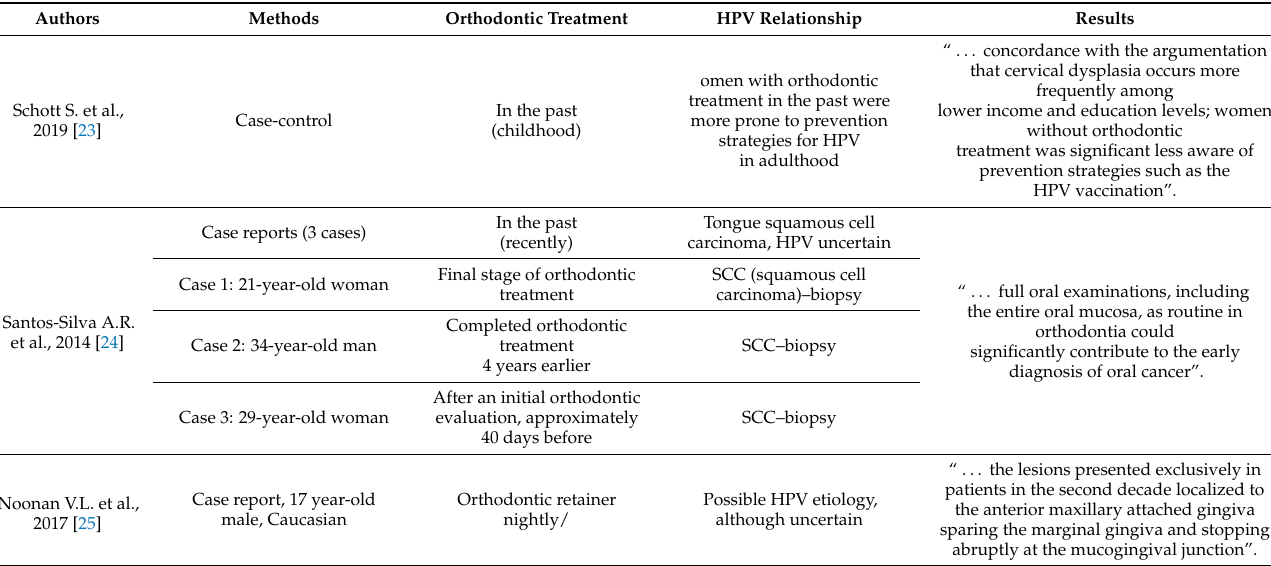
Figure 1. PRISMA flow diagram for research stages; literature search showed the following articles that reported a relationship between HPV and orthodontic treatment (Table 3). Table 3. Selected articles who met the inclusion